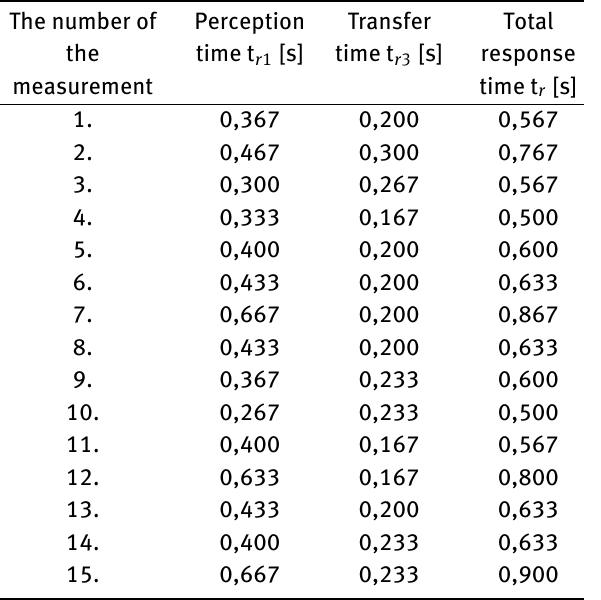
Table 18: Summary of the results of driver M. The number of the measurement